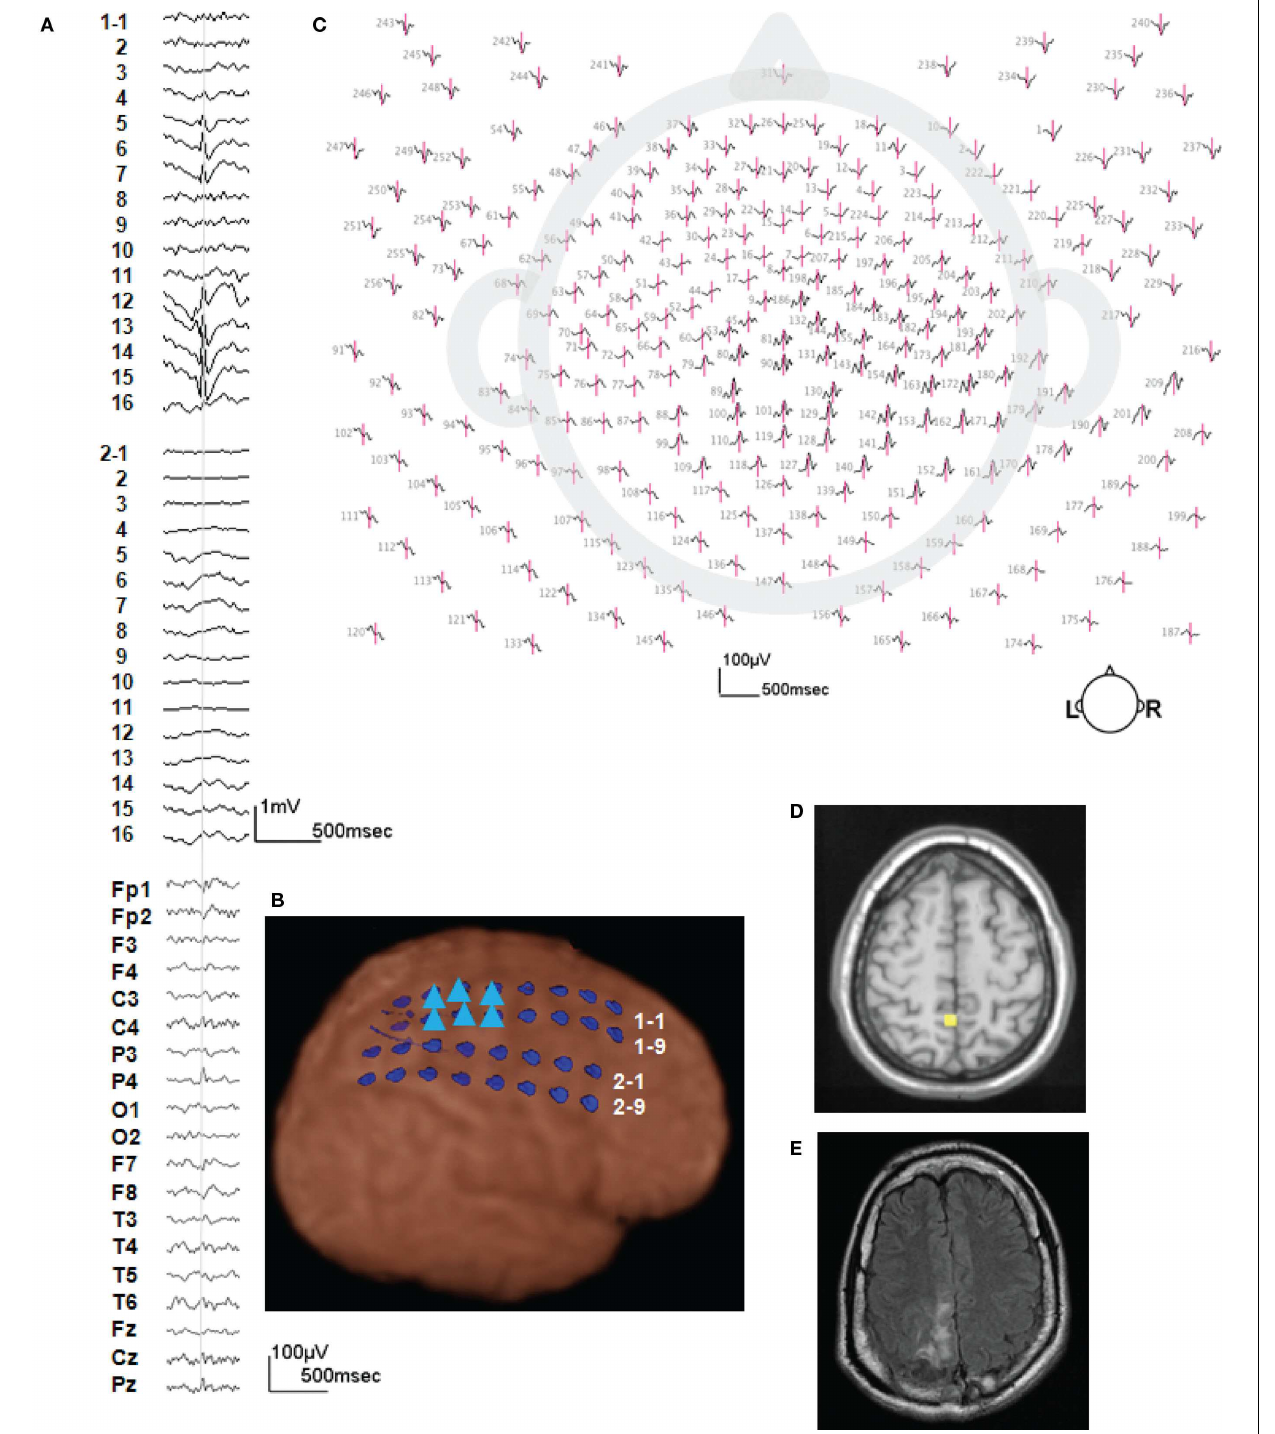
FIGURE 2 |A typical example of icEEG and dEEG source estimation (case 1) . (A) The icEEG (upper) shows a right parietal spike. Interictal spike is shown at electrodes # 1–5–7 and 12–16 which are located over the parietal region.The EEG (lower) is simultaneous recorded 256-channel dEEG with 19-channel of 10/20 display. (B) Placement of subdural electrodes and the location of the interictal spike. (cid:78) Indicates the electrodes which show the